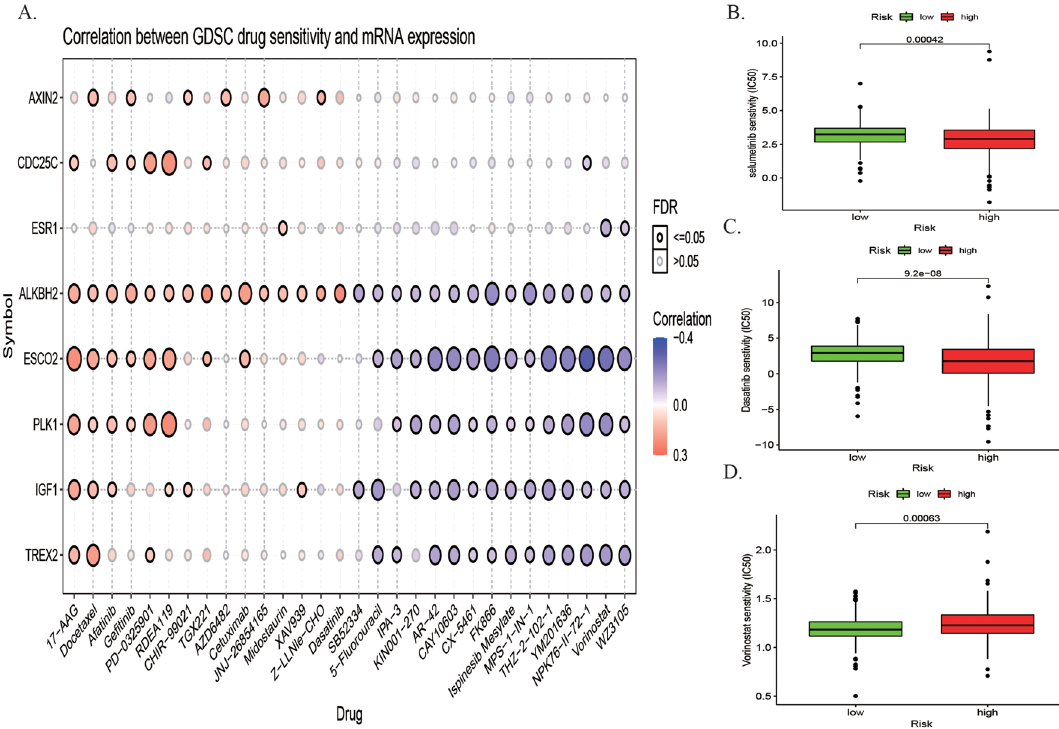
Figure 7. Analysis of drug sensitivity in risk model. (A) The correlation between GDSC drug sensitivity and 9 DE-DRGs mRNA expression. (B–D) The drug sensitivity of selumetinib, Dasatinib and Vorinostat in high-risk and low-risk